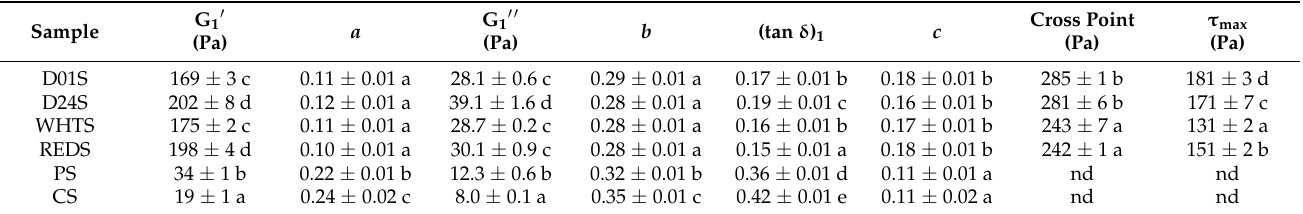
Table 4. Rheological properties of anchote, potato, and cassava starches.